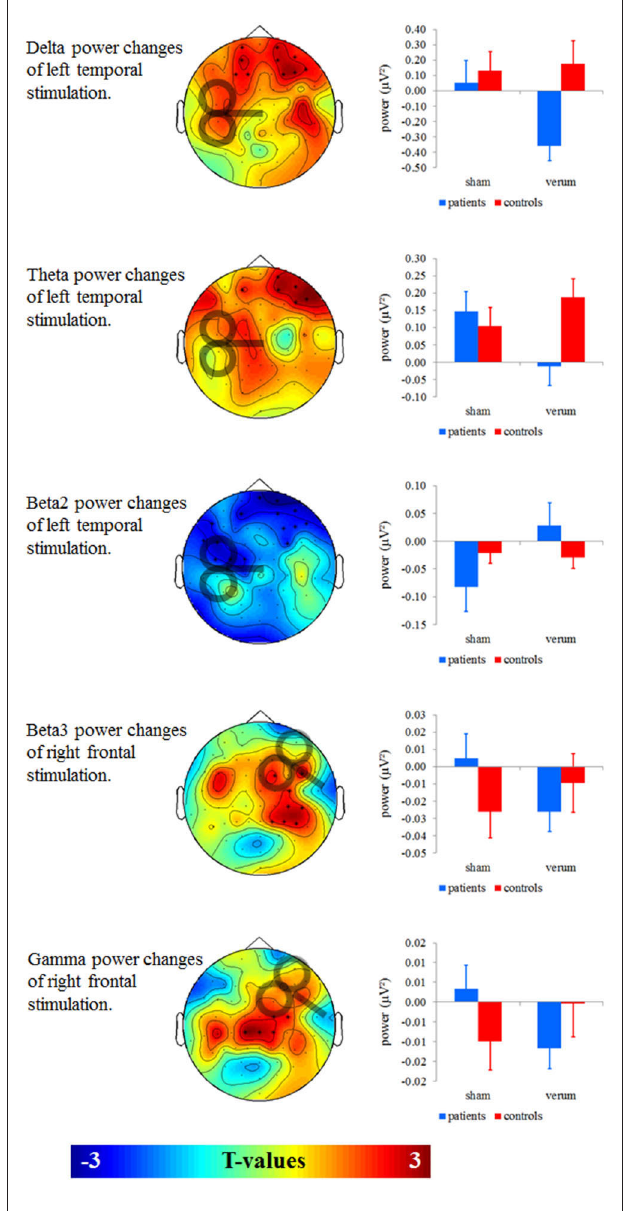
FIGURE 2 | Left : T-maps for baseline- and sham-controlled group contrasts. Significant clusters of electrodes are marked with asterisks. Right : Baseline-corrected mean power of significant clusters was given in a corresponding interaction term with the factors group and stimulation (verum vs.